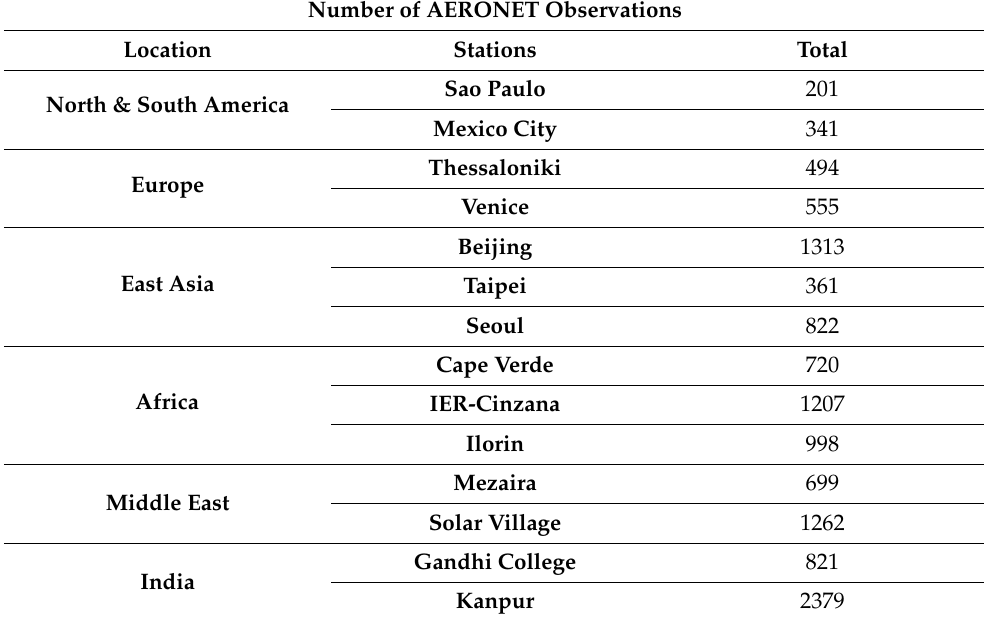
Table 2. The number of the considered AERONET observation for fourteen selected sites over the period